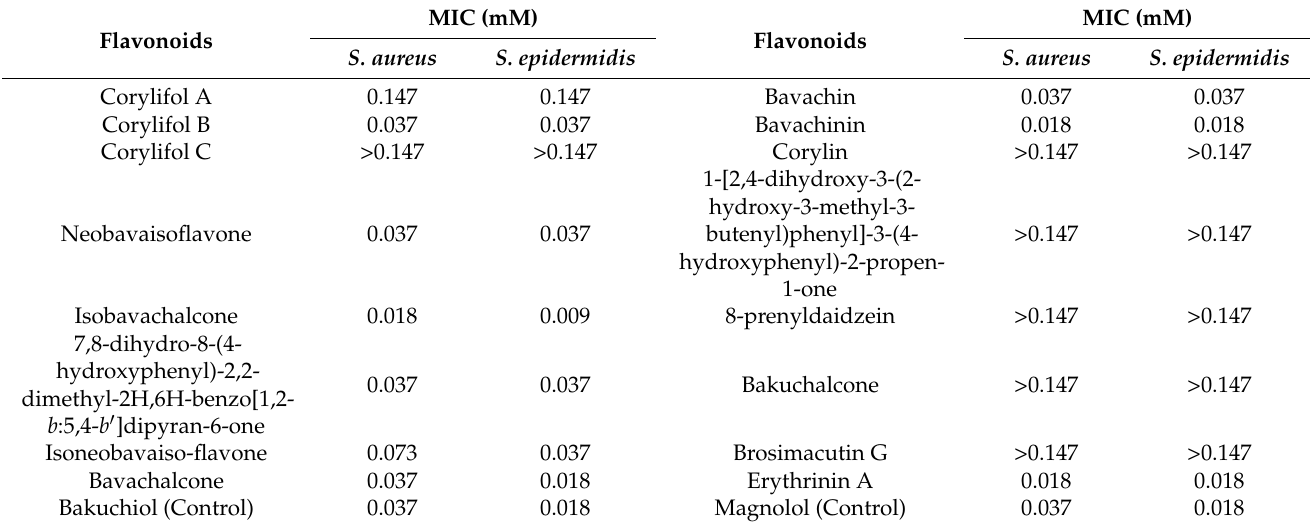
Table 7. Antibacterial activity of flavonoids isolated from Psoralea corylifolia